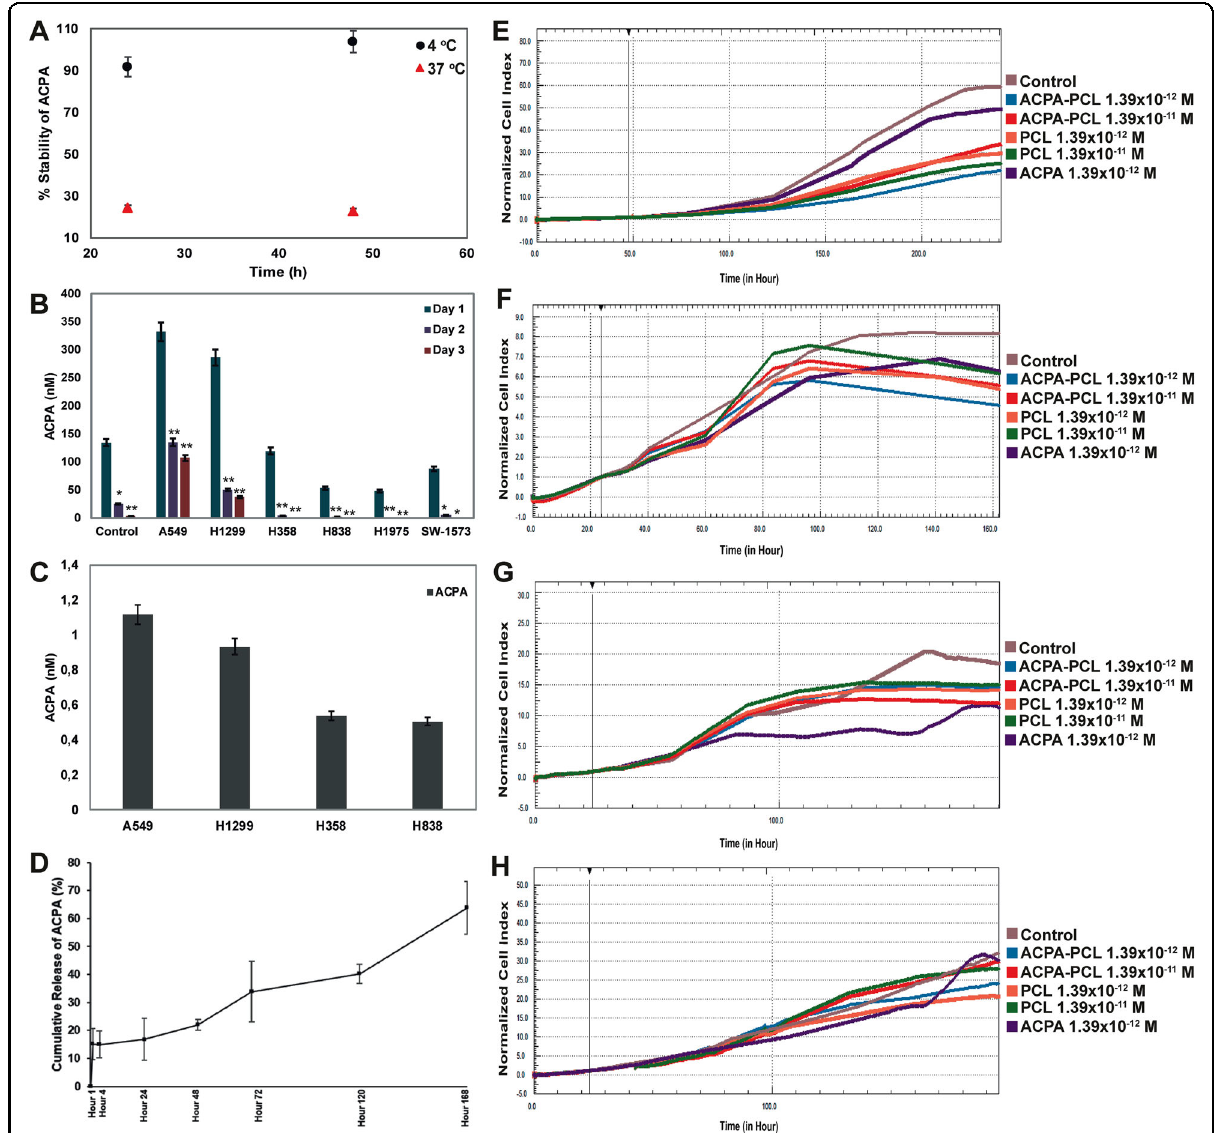
Fig. 6 ACPA is unstable after 24 hours and ACPA-PCL nanoparticle system provides a sustained release. a Stability of ACPA in percentage under 4 °C and 37 °C on days 1 and 2. b Amount of ACPA (nM) in cell-free and cell-containing media in control and A549, H1299, H358, H838, H1975, and SW-1573 cells on days 1, 2 and 3, * p < 0.01, ** p < 0.001 by one-way analysis of variance (ANOVA). Results are represented with mean ± SEM. c Amount of intracellular ACPA (nM) in A549, H1299, H358, and H838 cell lines on day 1 after administration. Values were normalized to normal culture media. d Cumulative release of ACPA from PCL nanoparticles (%) at hours 1, and 4, and days 1, 2, 3, 5, and 7. e , f , g , h Normalized cell indices over time assessed with RTCA for ( e ) A549, ( f ) H1299, ( g ) H358, and ( h ) H838 cells. Untreated controls, ACPA-PCL nanoparticles releasing low dose window, diluted empty PCL nanoparticles and 1.39 × 10 − 12 M dose of ACPA-treated groups are shown for each cell line. All experiments were conducted